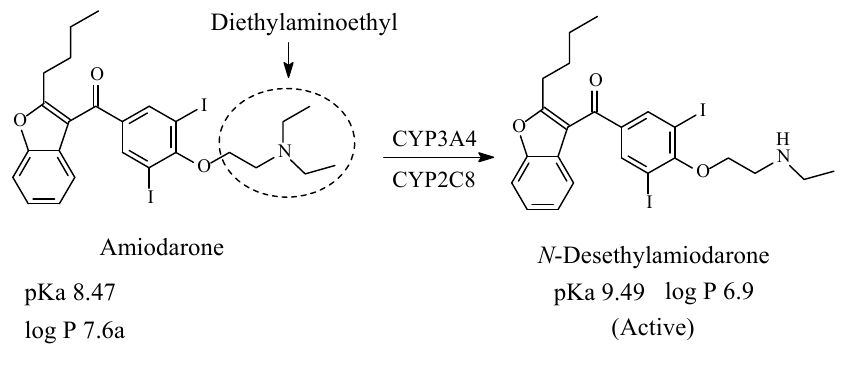
Figure 31. Metabolism of amiodarone.